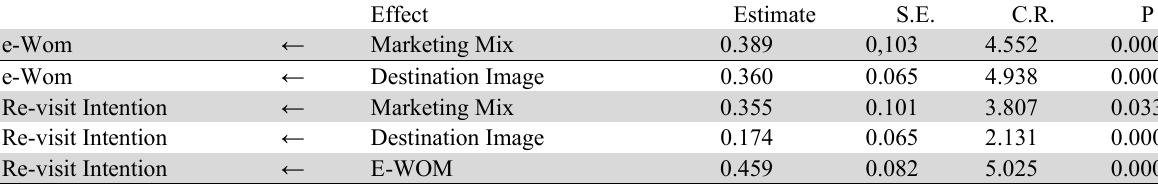
Standardized Regression Weight Structural Equational Model